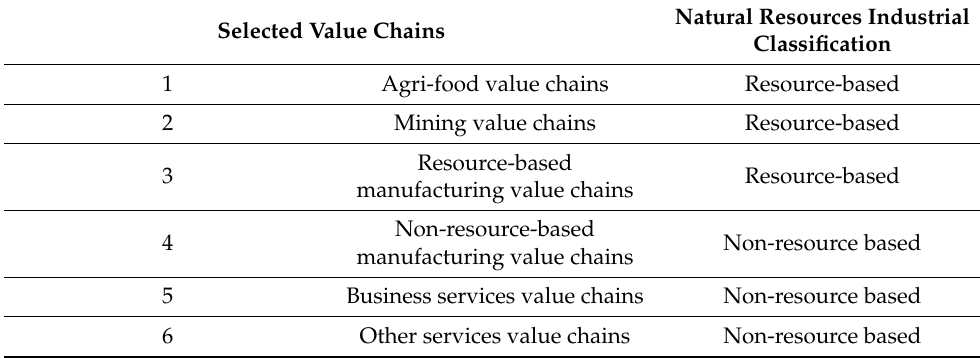
Table 2. Large selected industrial groups (value chains